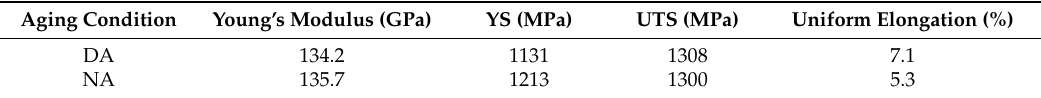
Table 2. Tensile properties of the Cu-Be-Co-Ni alloys under different aging conditions.